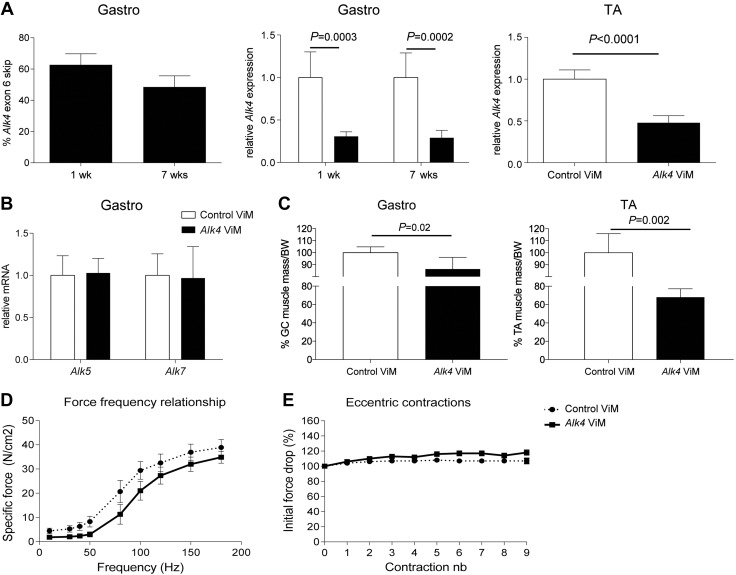
Alk4 exon skipping decreases gastrocnemius muscle mass but has no effect on muscle physiology in WT mice. A) Percentages of exon skipping of Alk4 or control ViM-injected gastrocnemius muscles after 1 and 7 wk of treatment were measured. Specific Alk4 transcript down-regulation in gastrocnemius (n = 6) and tibialis anterior (n = 4) muscles was measured. B) qPCR was performed to measure Alk5 and Alk7 transcripts of long-term Alk4 or control ViM-injected gastrocnemius muscles. No differences were detected after the treatment in either transcript. C) Weighing of the Alk4 ViM-treated gastrocnemius muscles showed a 25% decrease and tibialis anterior muscles showed a 30% decrease in mice relative to control ViM. Muscle weights were normalized to the body weights at the endpoint of the experiment. D) Force vs. frequency for the tibialis anterior muscles of treated intramuscularly with Alk4 ViM and contralaterally with control ViM for 7 wk (n = 8). Each data point represents the force measured at each frequency. No significant differences in the total force were measured between control and Alk4 ViM-treated muscles. E) Relative changes in tetanic force during 9 cycles of eccentric contraction in tibialis anterior muscles (n = 8) treated intramuscularly with Alk4 ViM and contralaterally with control ViM for 7 wk. The tetanic tension developed during the second cycle was taken as 100%. No significant differences in the initial force drop between control and Alk4 ViM-treated muscles were measured. Error bars, sd (A–C) and sem (D, E).